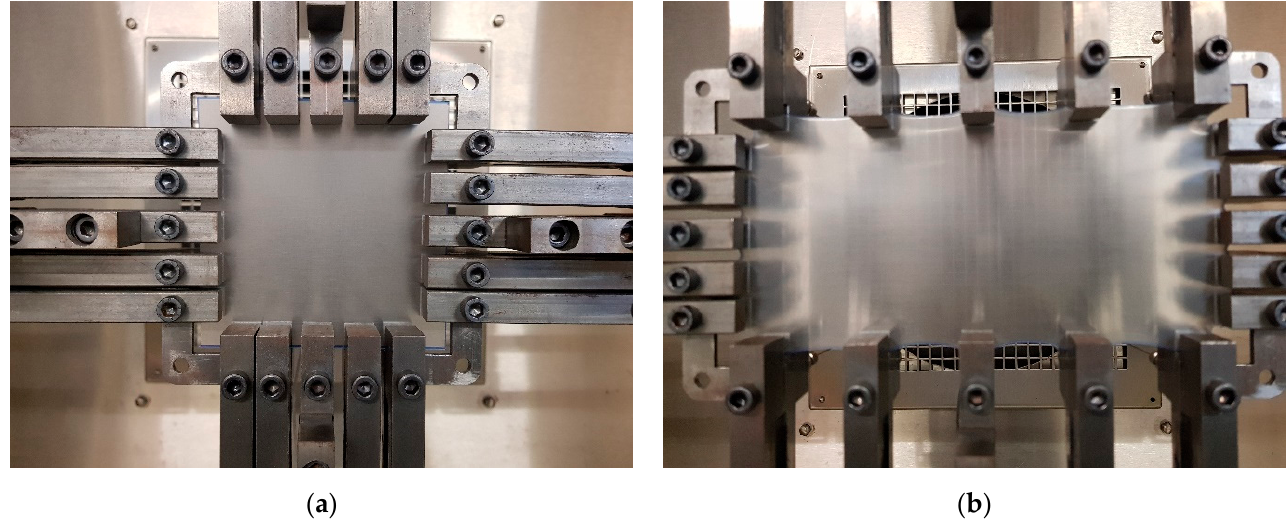
Figure 1. Specimen in biaxial machine ( a ) initially and ( b ) after planar stretch along the axial (horizontal) direction.